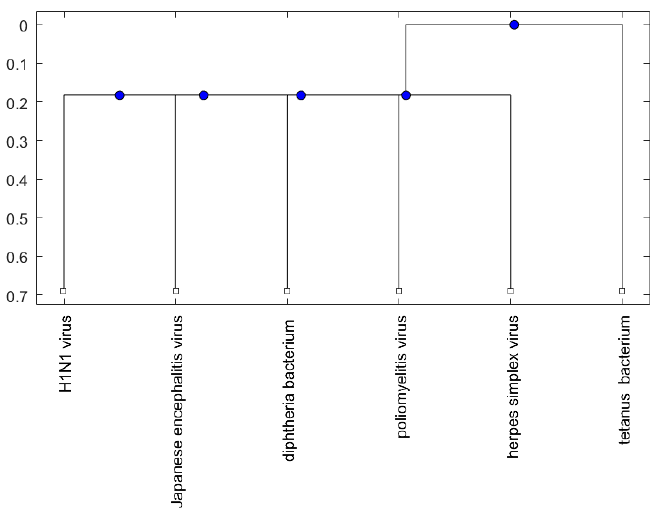
Figure 6. The phylogenetic tree of virus or bacterium based on the p-distance and median linkage